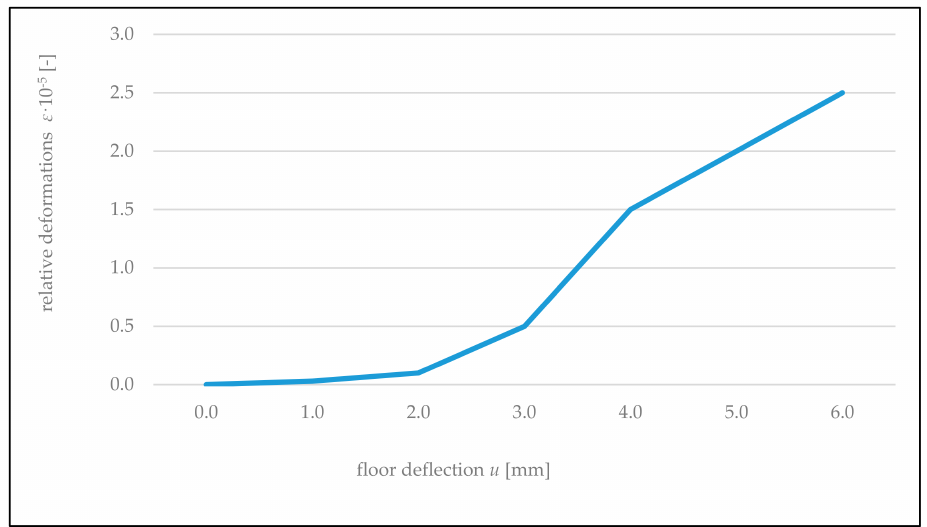
Figure 19. The dependency of floor deflection u on the relative deformations ε of the wall at an angle of 45 ◦ in corners of the door opening for the wall not connected with cross walls.